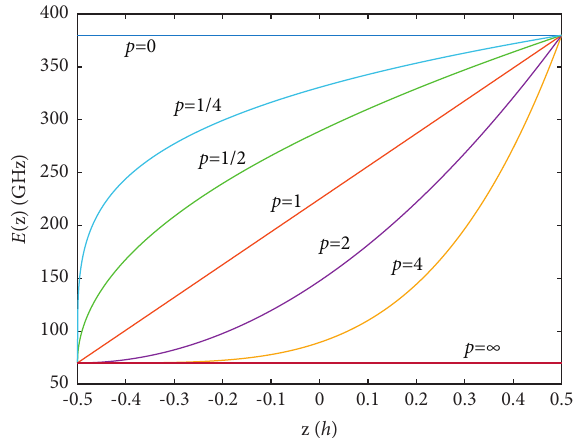
Figure 2: Variation of material Young’s modulus along thickness.